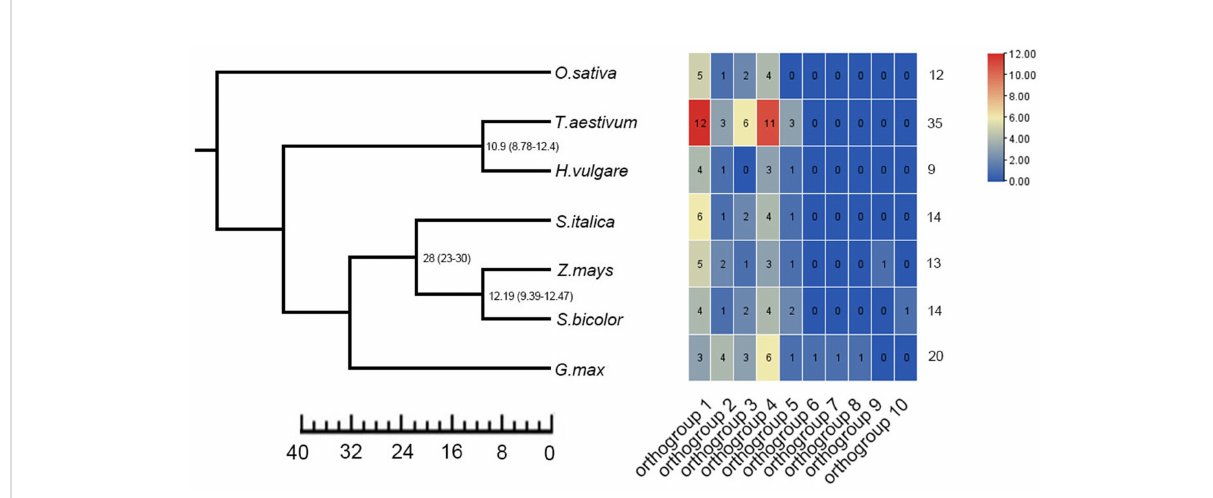
FIGURE 1 Identi fi cation of TLP genes in seven crops. Ten orthogroups and number of TLP genes in different species were shown by heat map. The value was represented in